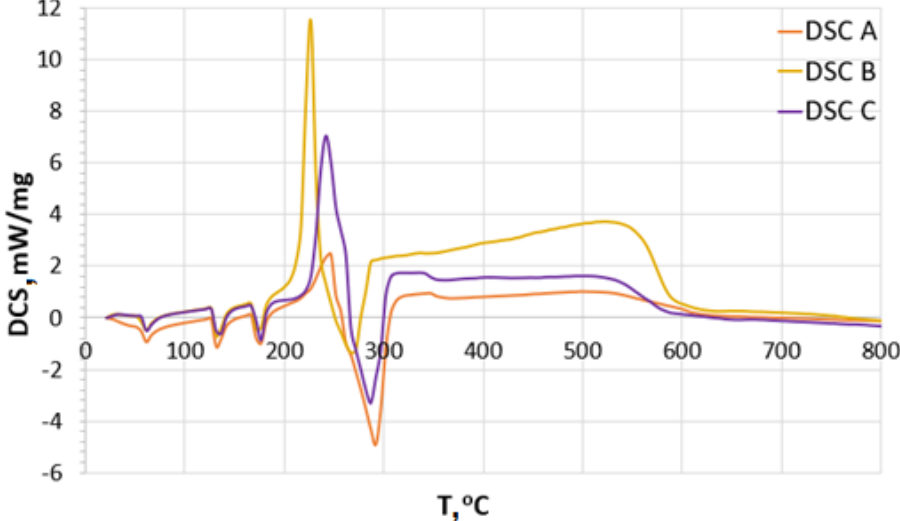
Figure 8. DSC results of explosives containing microstructure charcoal grains of 1.18 mm, sample 2 (TG A), sample 3 (TG B), sample 4 (TG C).